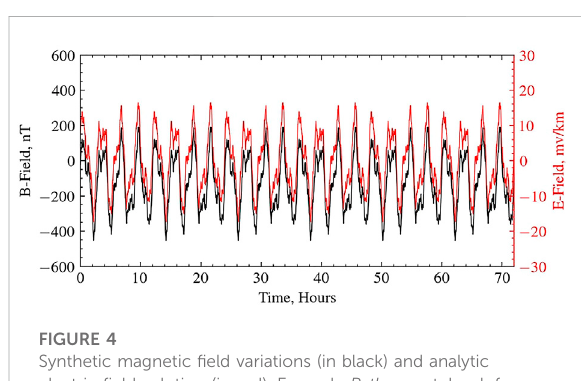
FIGURE 4 Synthetic magnetic fi eld variations (in black) and analytic electric fi eld solution (in red). Example Python notebook for generating thesyntheticmagnetic fi